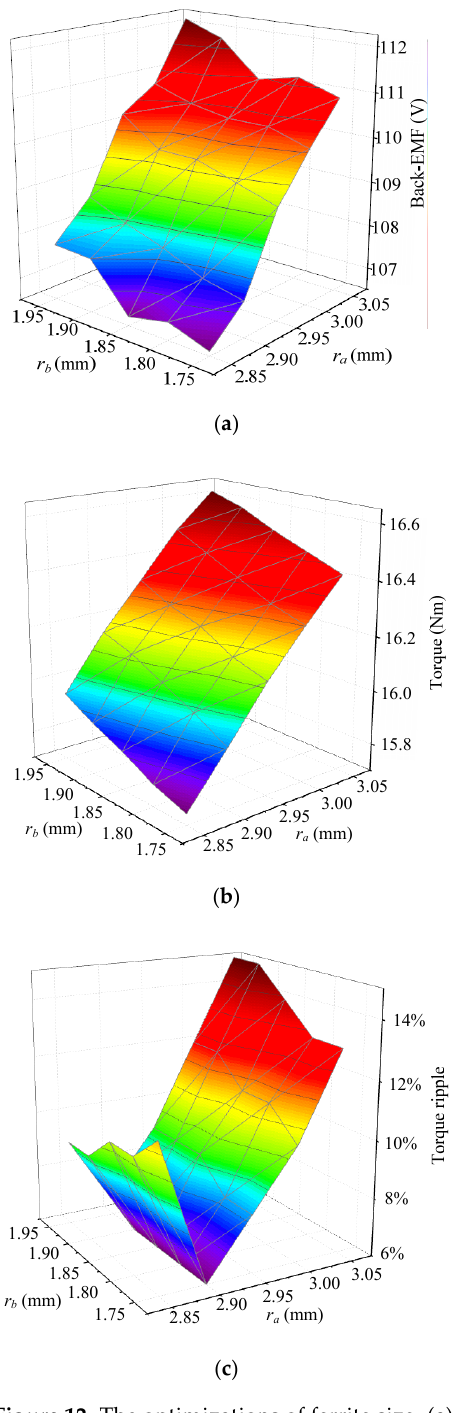
Figure 12. The optimizations of ferrite size. ( a ) Back-EMF. ( b ) Average torque. ( c ) Torque ripple.